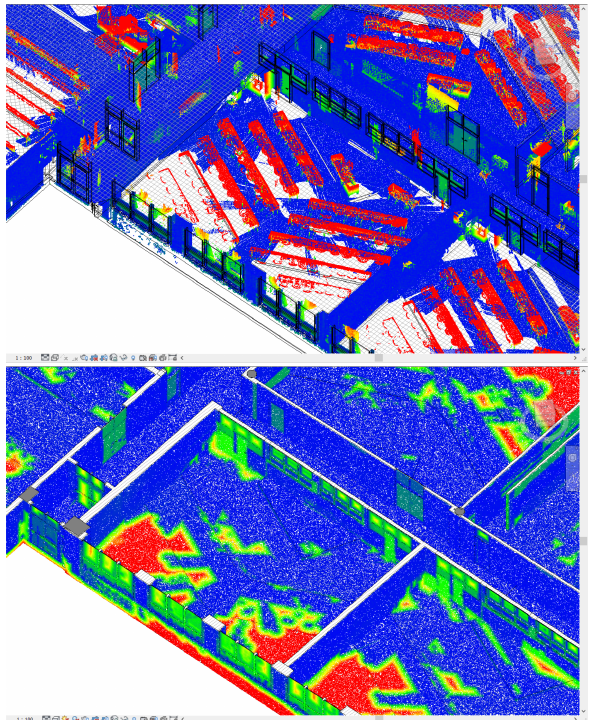
Figure 5. Results of macro scale analysis imported in Revit as colored point clouds Top: colored ‘model point cloud’ Bottom: colored ‘original point